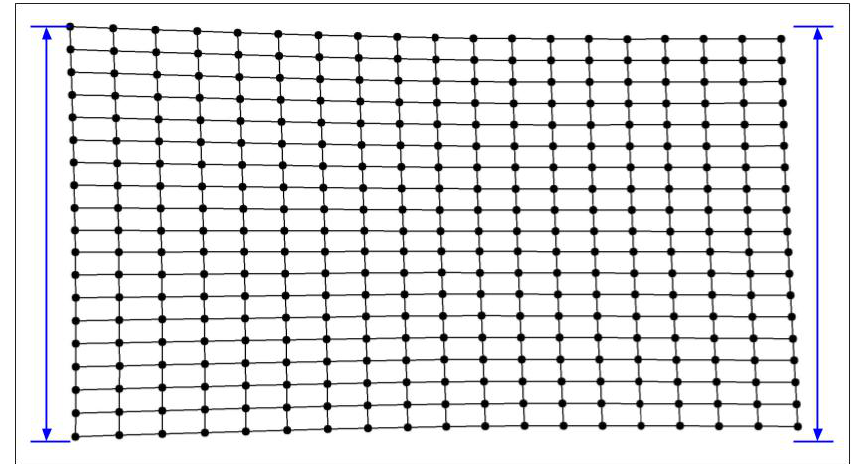
Figure 15. Image distortion